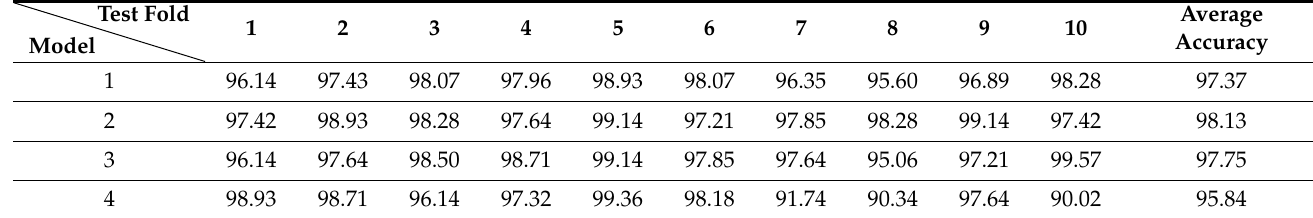
Table 7. Cross-validation results for different multilayer CNN models ( K f =